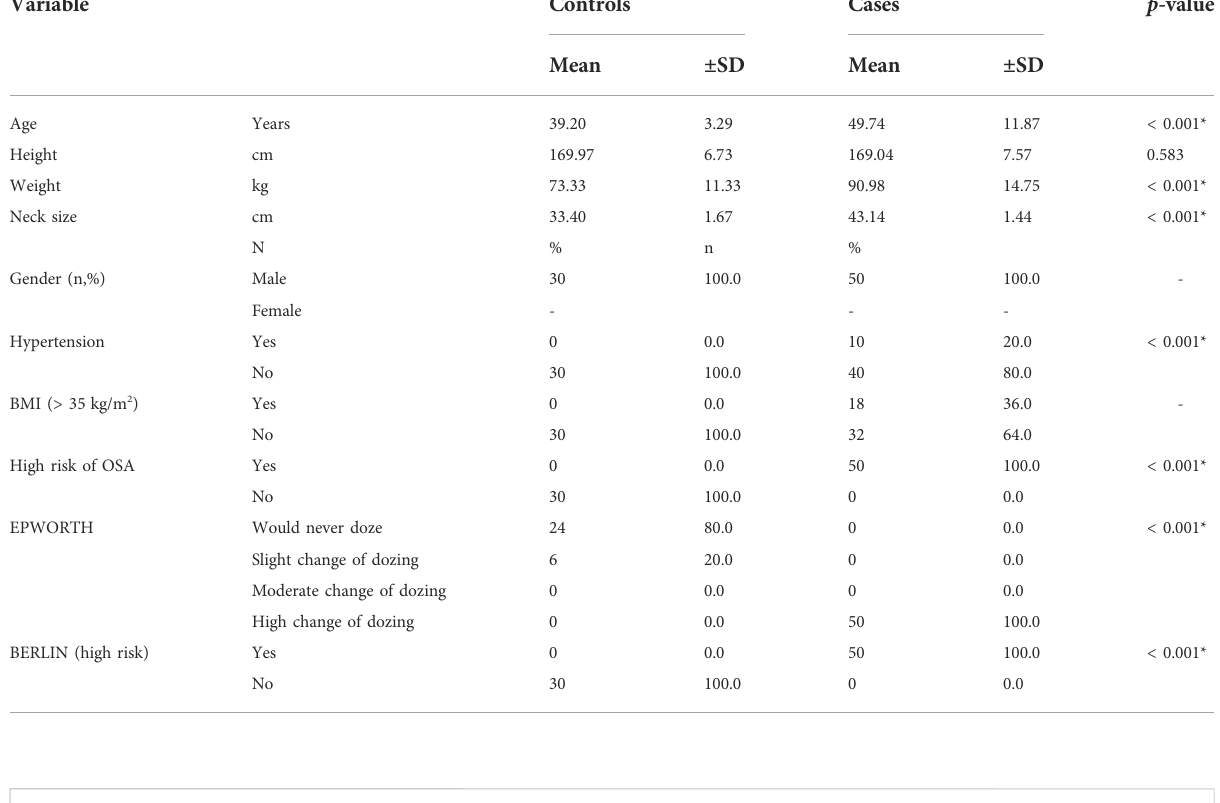
TABLE 1 Baseline characteristics of case and controls.